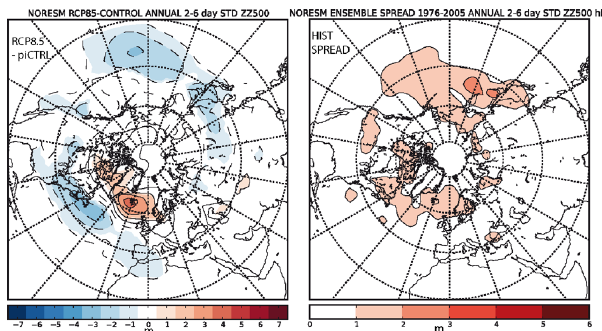
Fig. 12. NorESM1-M simulated change from 1976–2002 to 2071– 2100 in NH extra-tropical storminess, diagnosed as described in Fig. 11, using the RCP8.5 projection scenario (left). Colours in- dicate significant changes on the 95% confidence level. The right panel shows the standard deviation in the storminess amongst the three ensemble-members Historic1–3 for 1976–2005, revealing that the significant changes diagnosed in the left panel are considerably larger for the main